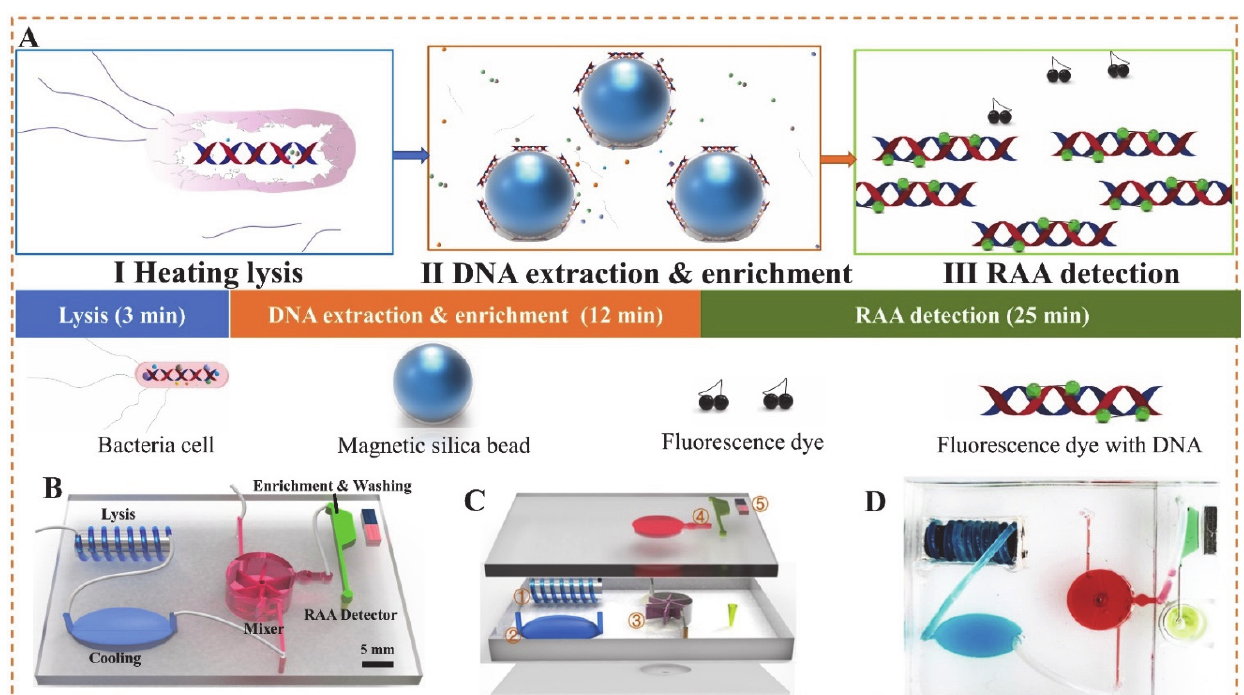
Figure 1. The schematic of this microfluidic chip for Salmonella typhimurium detection. ( A ) The procedure of bacterial detection. ( B ) The structure of the microfluidic chip. ( C ) The components of the microfluidic chip: ① the spiral lysis channel, ② the ellipsoidal cooling chamber, ③ the fan ‐ shaped mixer, ④ the trapezoid separation chamber, ⑤ the magnet. ( D ) The photo of the microfluidic chip.